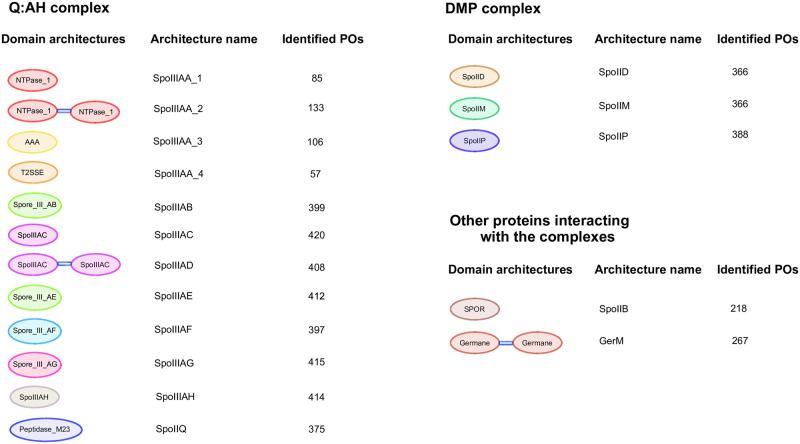
Architectures of the Q: AH and DMP complexes and accessory proteins.Pfam architectures that were used as models to scan for the PO in bacterial proteomes and its frequency of appearance in Firmicutes.